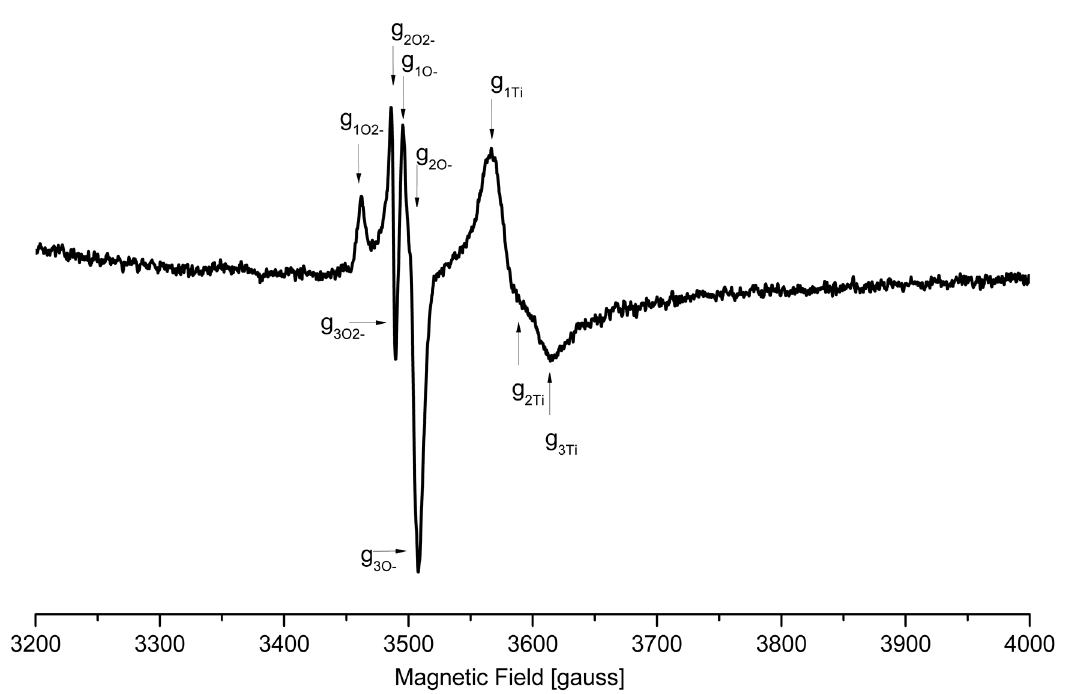
Figure 7. EPR spectrum of UV-Vis irradiated PMMA foil with complex ( 1 ). 7. Results